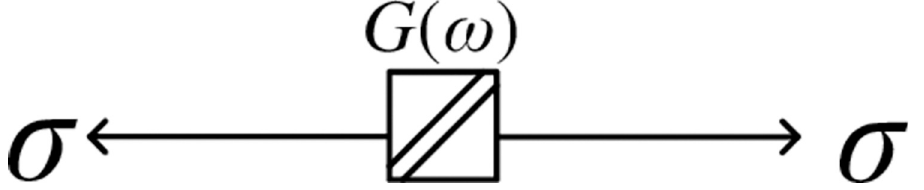
Fig 11. Nonlinear rheological